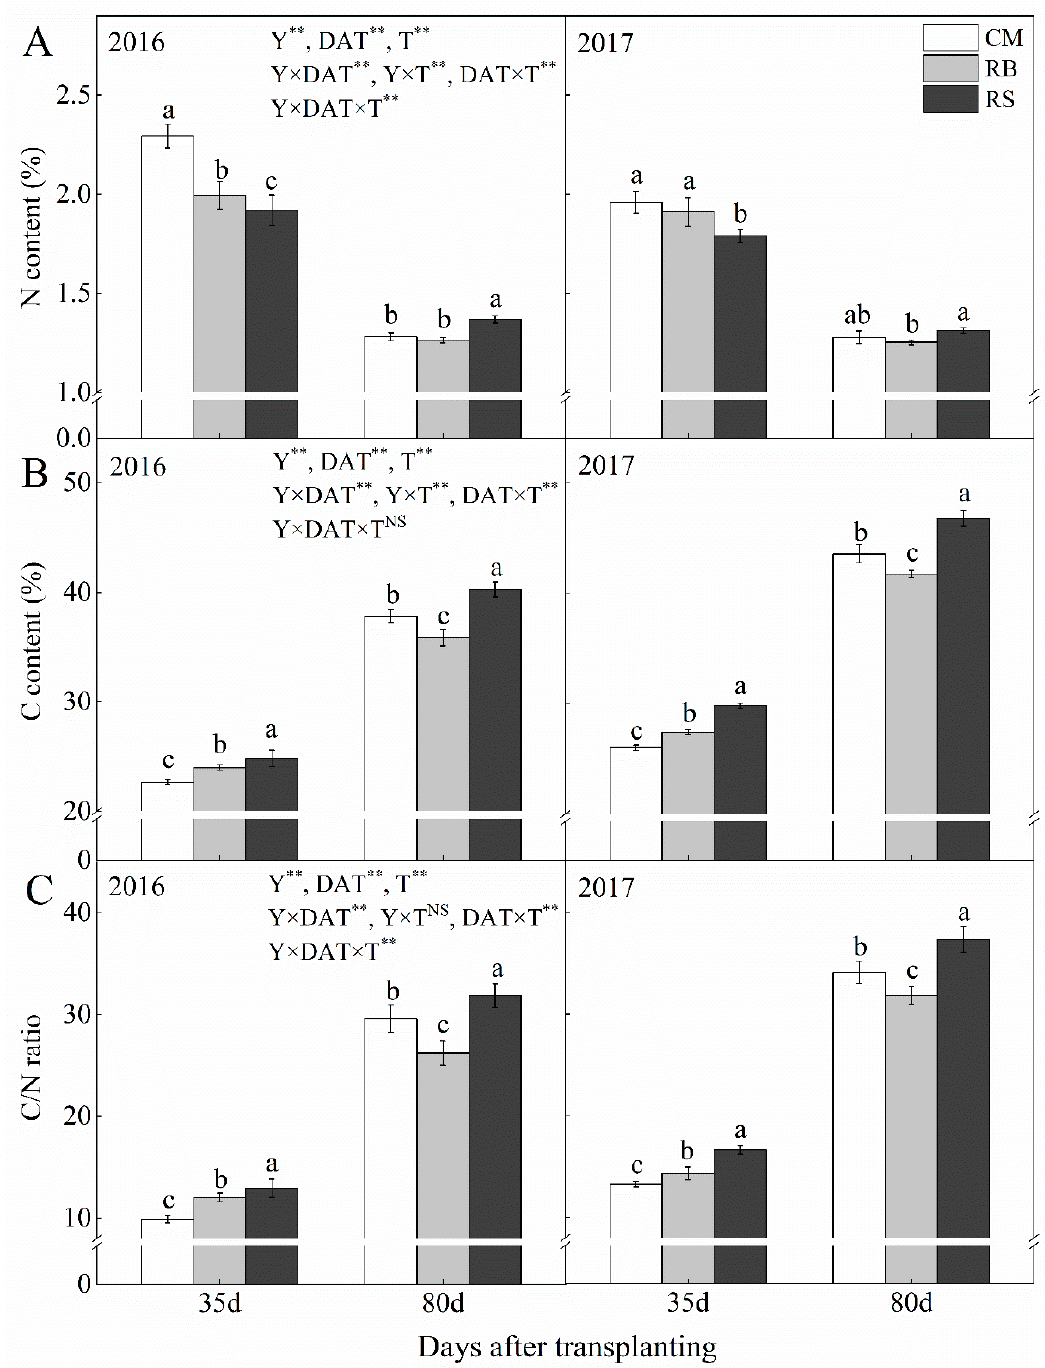
Figure 3. N content ( A ), C content ( B ) and C / N ratio ( C ) in the storage root in the three N management strategies at 35 and 80 DAT in 2016 and 2017. Note: CM: conventional N management; RB: 20.0% reduced N was applied as basal; RS: split application of 20.0% reduced N at transplanting and 35 DAT. Y, year; DAT, days after transplanting; T, treatment. Values are the treatment means for a given management strategy within a particular year ( n = 3). Error bars represent the standard error of the mean. * indicate significance at p < 0.05 probability level. ** indicate significance at p < 0.01 probability level. NS indicate no significance. The different lowercase letters in the same column indicate significant differences at p ≤ 0.05.